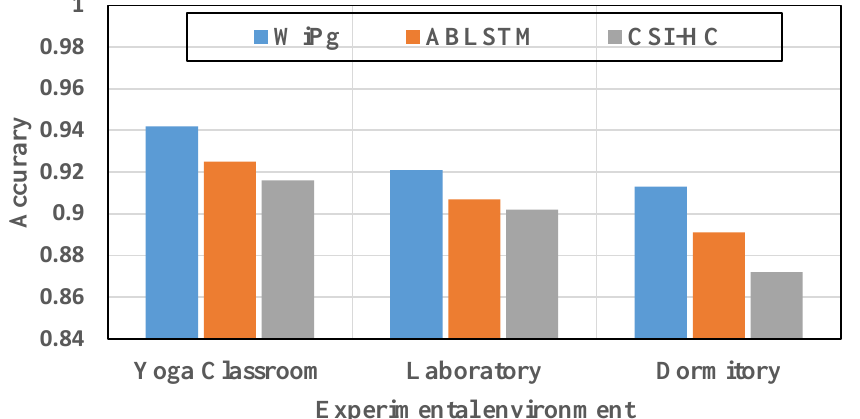
Figure 18. Robustness comparison.